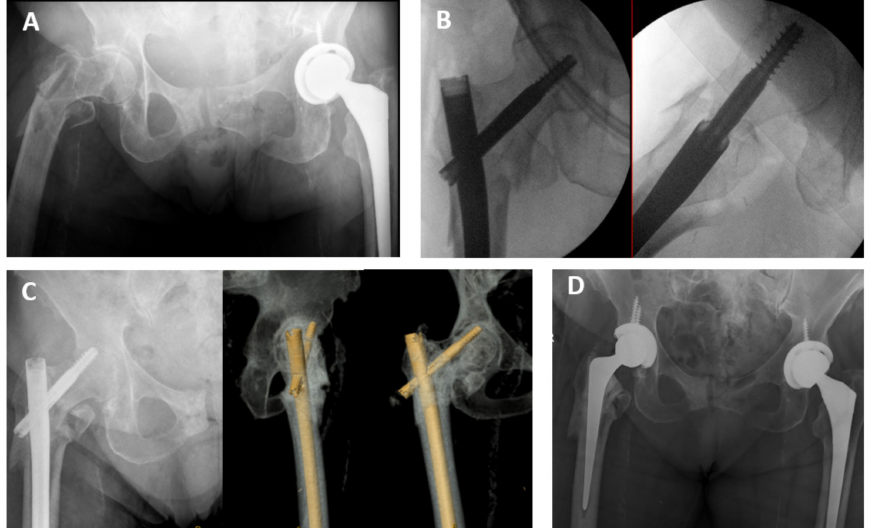
Figure 2. A comminuted A3.3 fracture variant with a 32 mm length lesser trochanter fragment treated with a proximally engaged long femoral nail post-inclusion period ( A ). The lag screw despite having an acceptable TAD of 18 mm and lateral engagement is in Cleveland zone 4 ( B ). It was cut out at post-operative day 287 ( C ) and was revised to a hybrid total hip replacement ( D